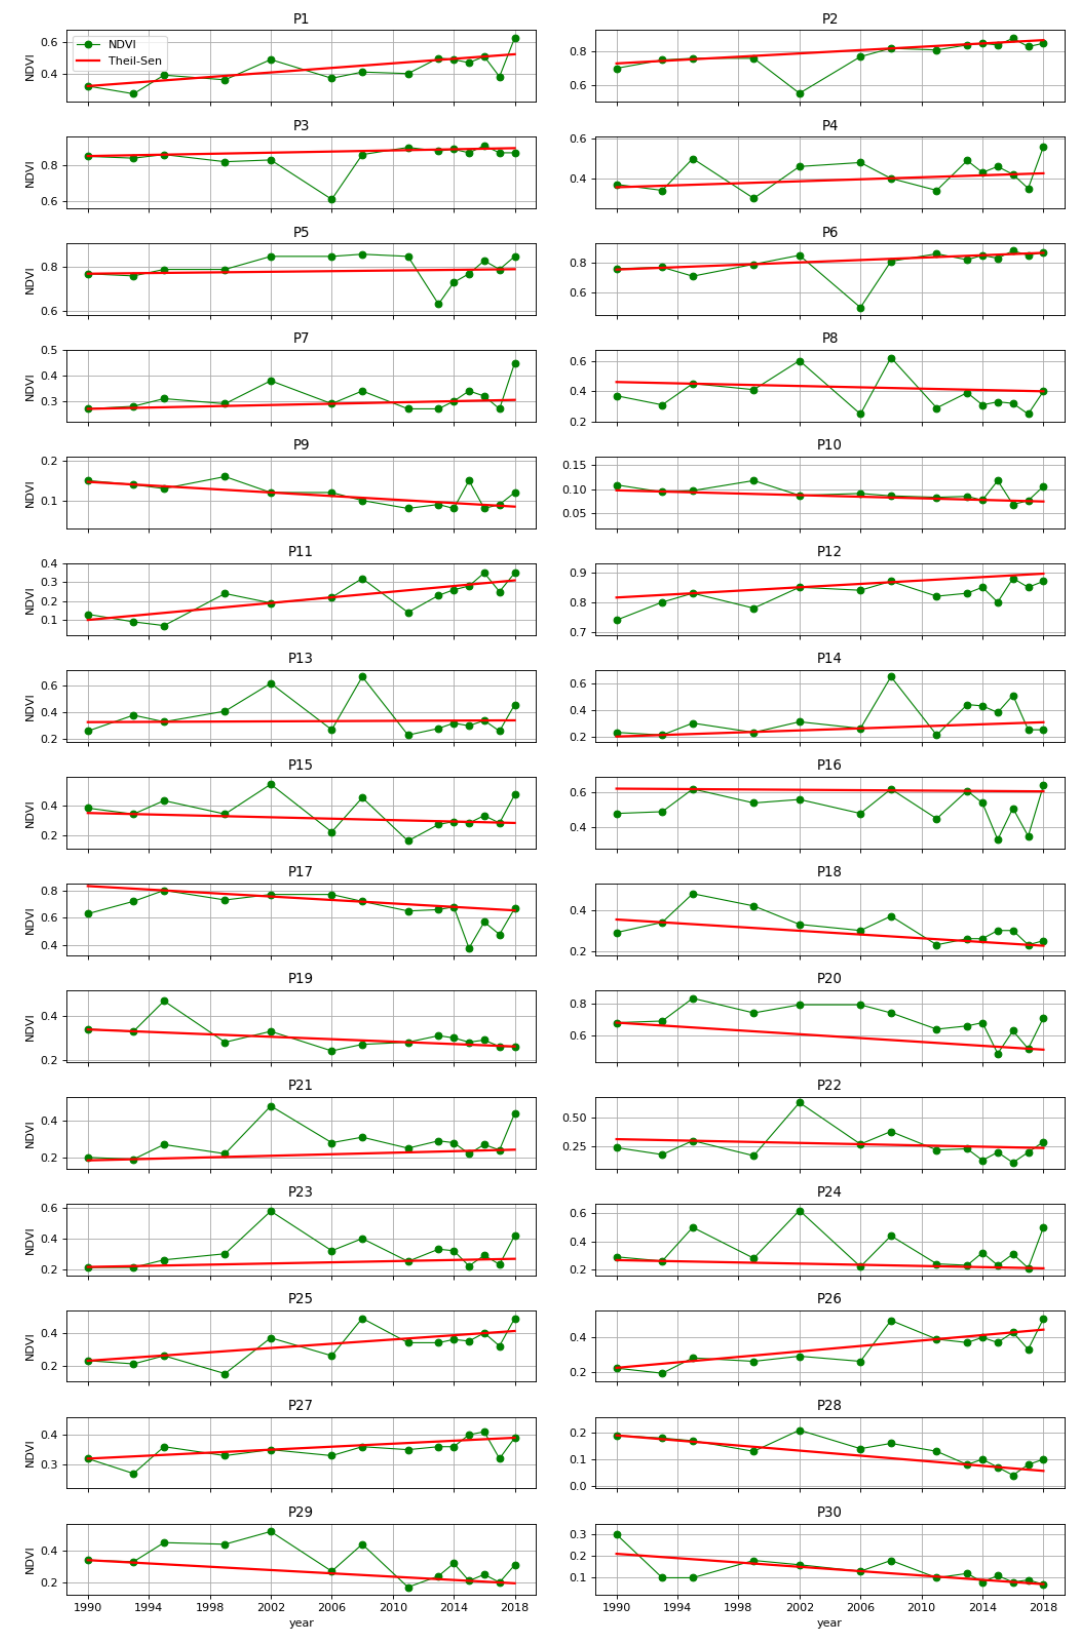
Figure 10. Theil–Sen median trend of sampled points (from P1 to P10 Aia dei Monaci; from P11 to Figure 10. Theil – Sen median trend of sampled points (from P1 to P10 Aia dei Monaci; from P11 to P20 Montegrosso-Pallareta; from P21 to P30 Vallone Calabrese). P20 Montegrosso-Pallareta; from P21 to P30 Vallone